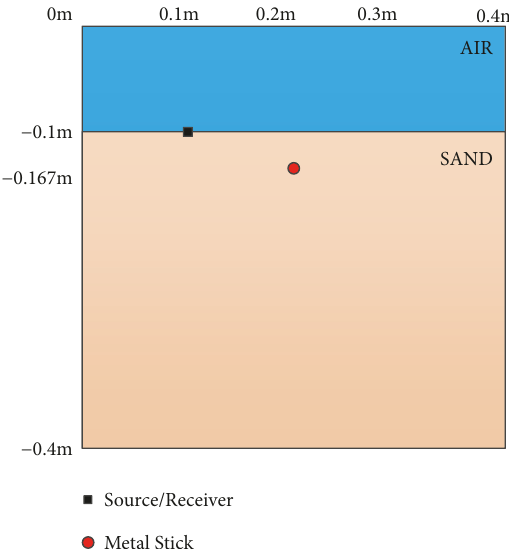
Figure 3: Locations of the first transmitter/receiver and the target.